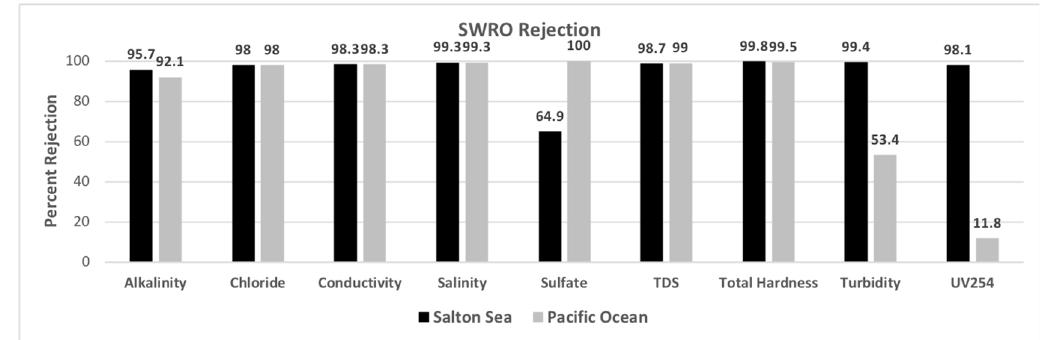
Figure 14. SWRO contaminant rejection.